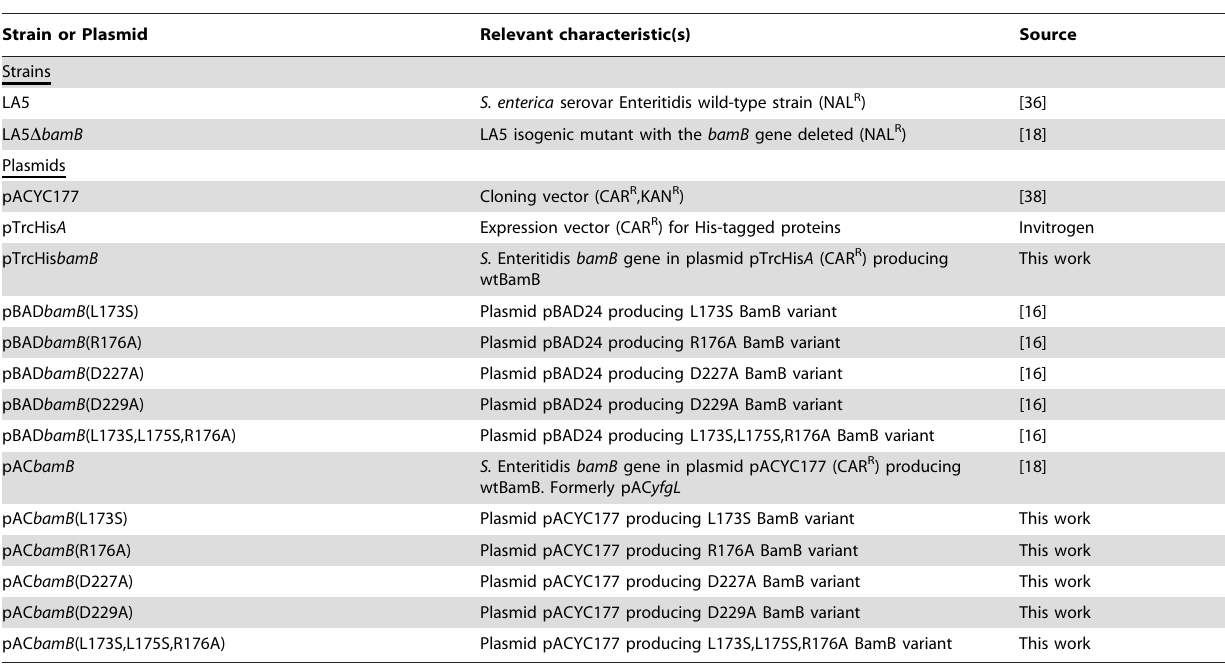
Table 2. Bacterial strains and plasmids used in this study.